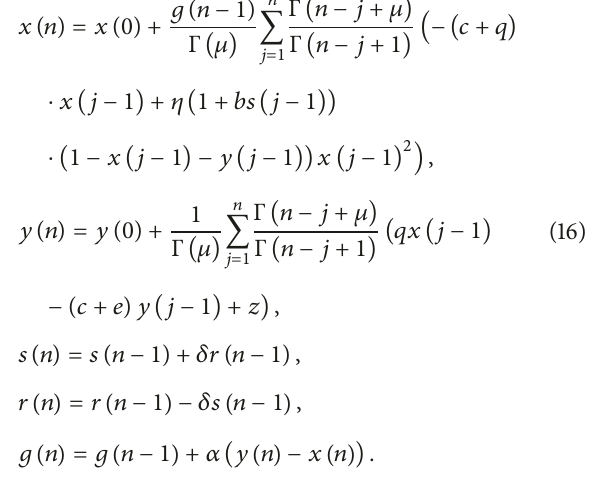
respectively, to achieve the control of Julia set. Controllers are added to different positions of the system as a whole, a part, and a product factor. The design methods are not